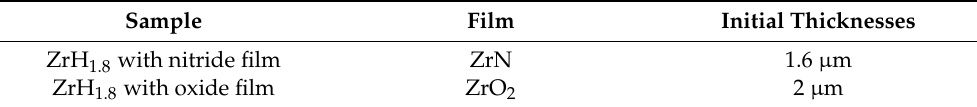
Table 2. Samples investigated for hydrogen permeation